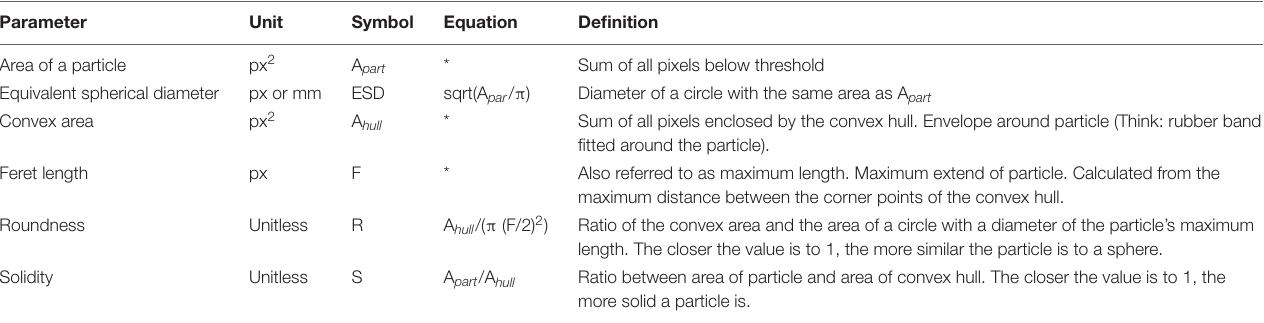
TABLE 2 | Particle size